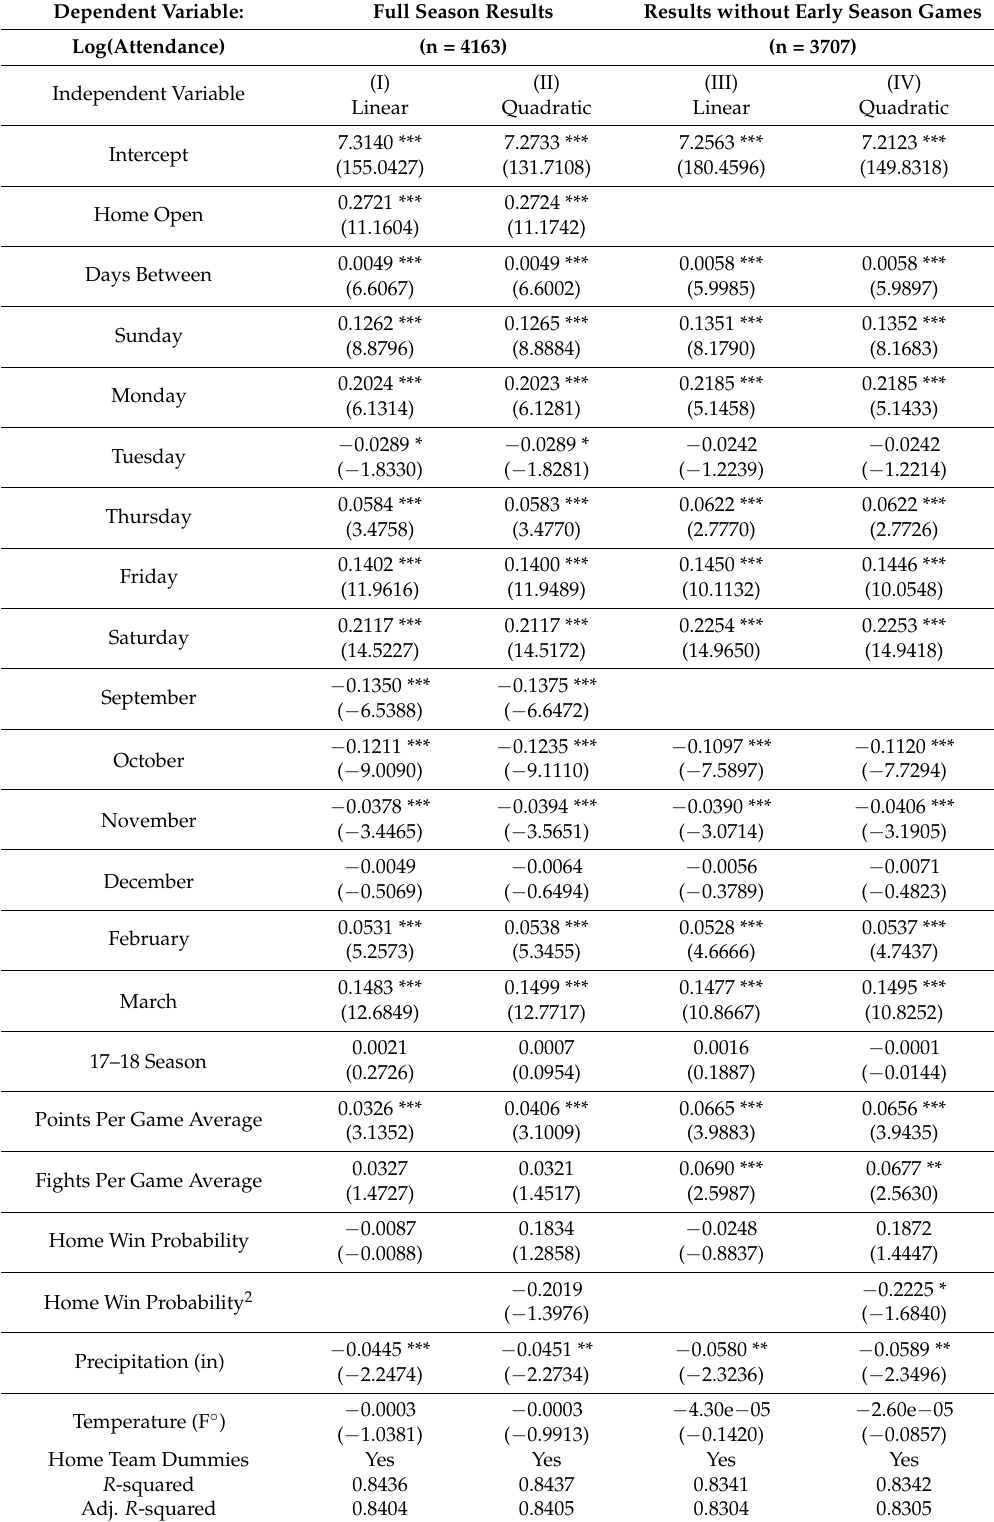
Table 2. Regression results for Canadian Hockey League (CHL) attendance model 2016–17 to 2017–18